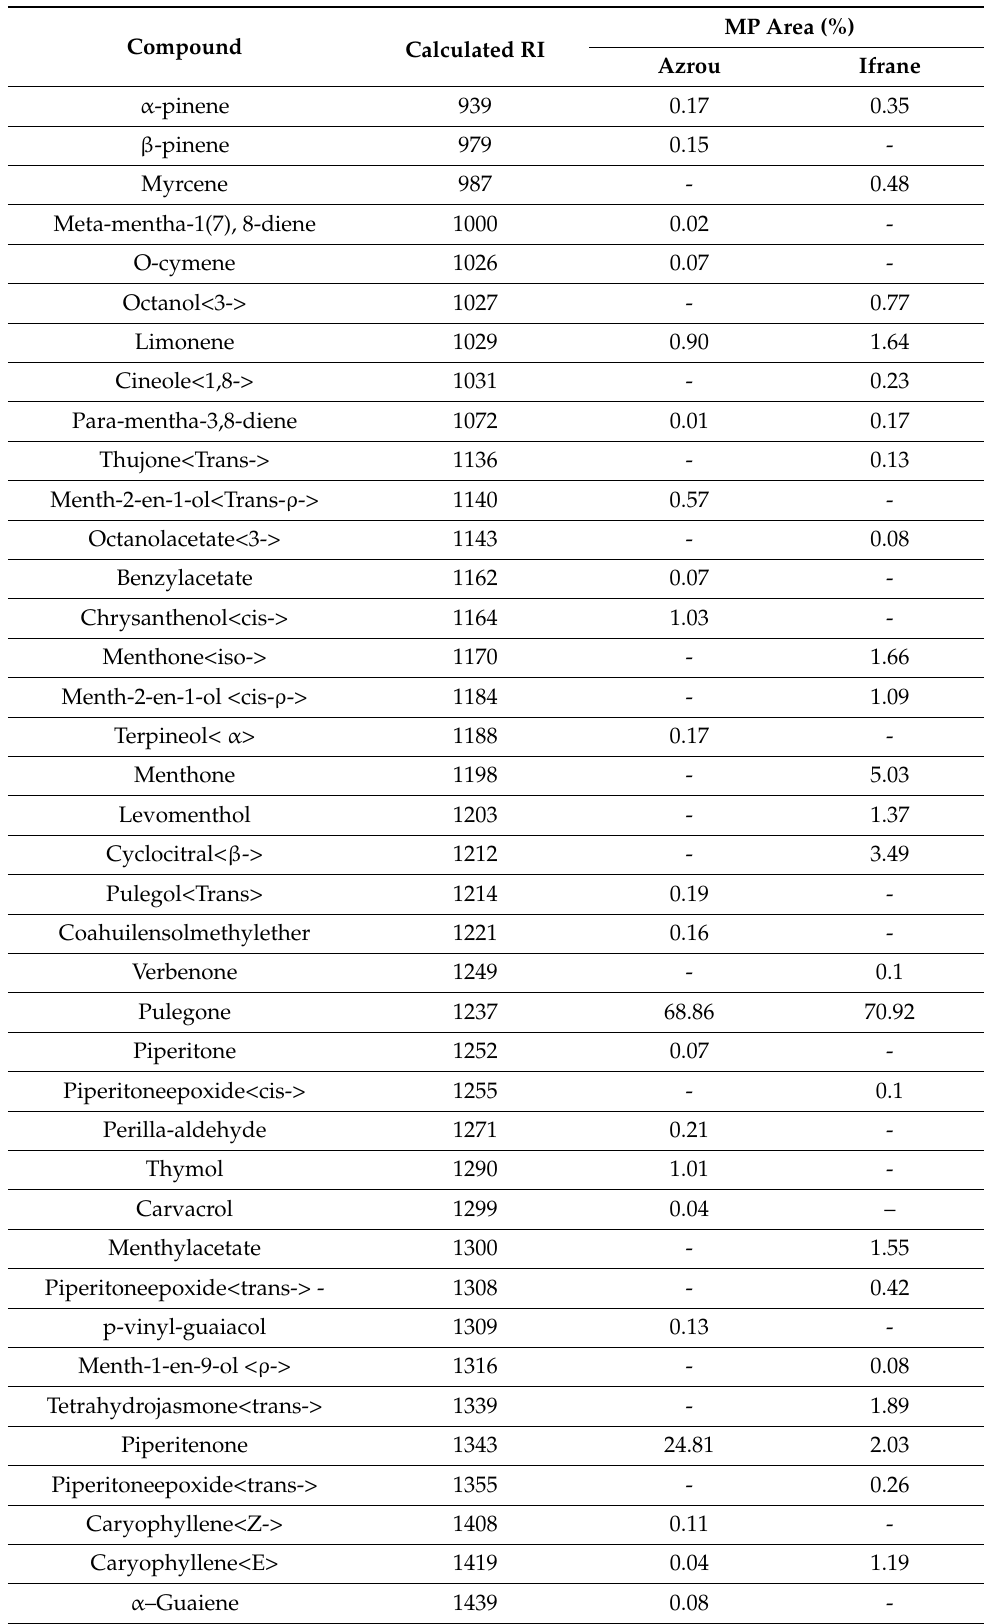
Table 3. Chemical composition of M. pulegium (L.) EOs from the Middle Atlas.